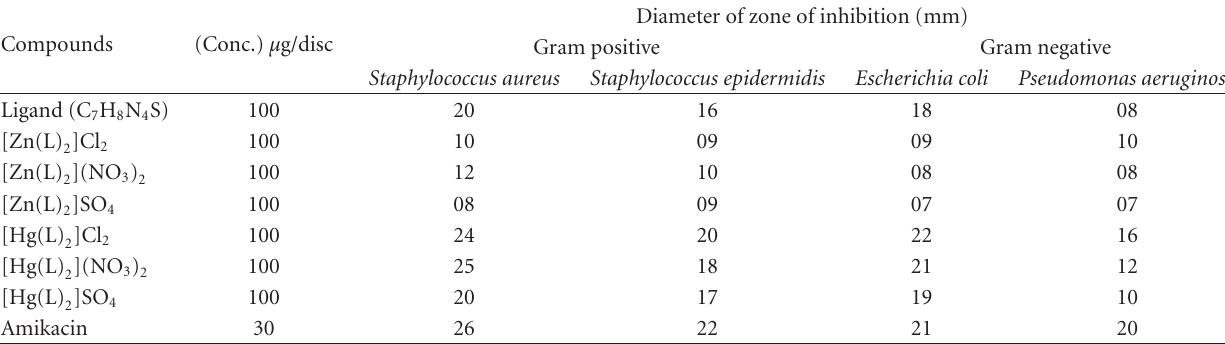
Table 3: Antibacterial screening data of the ligand and its Zn(II) and Hg(II)